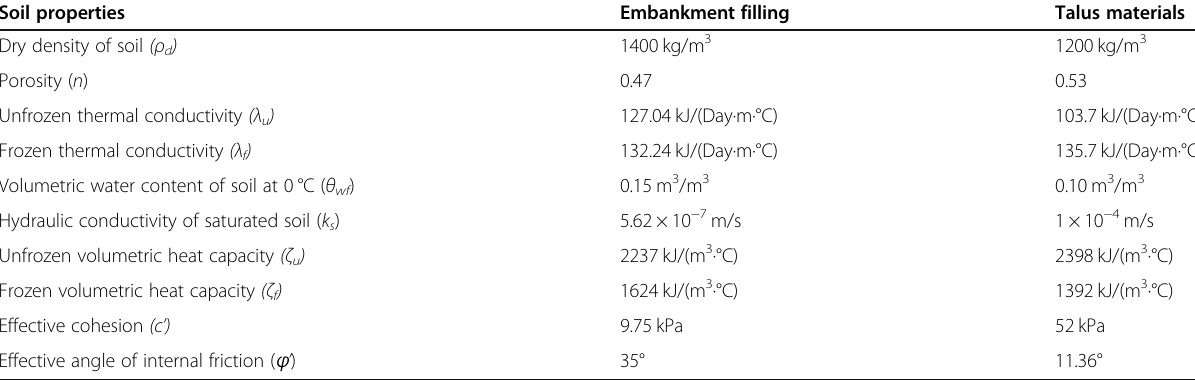
Table 4 Soil properties of the actual highway slope at Nakayama Pass Soil